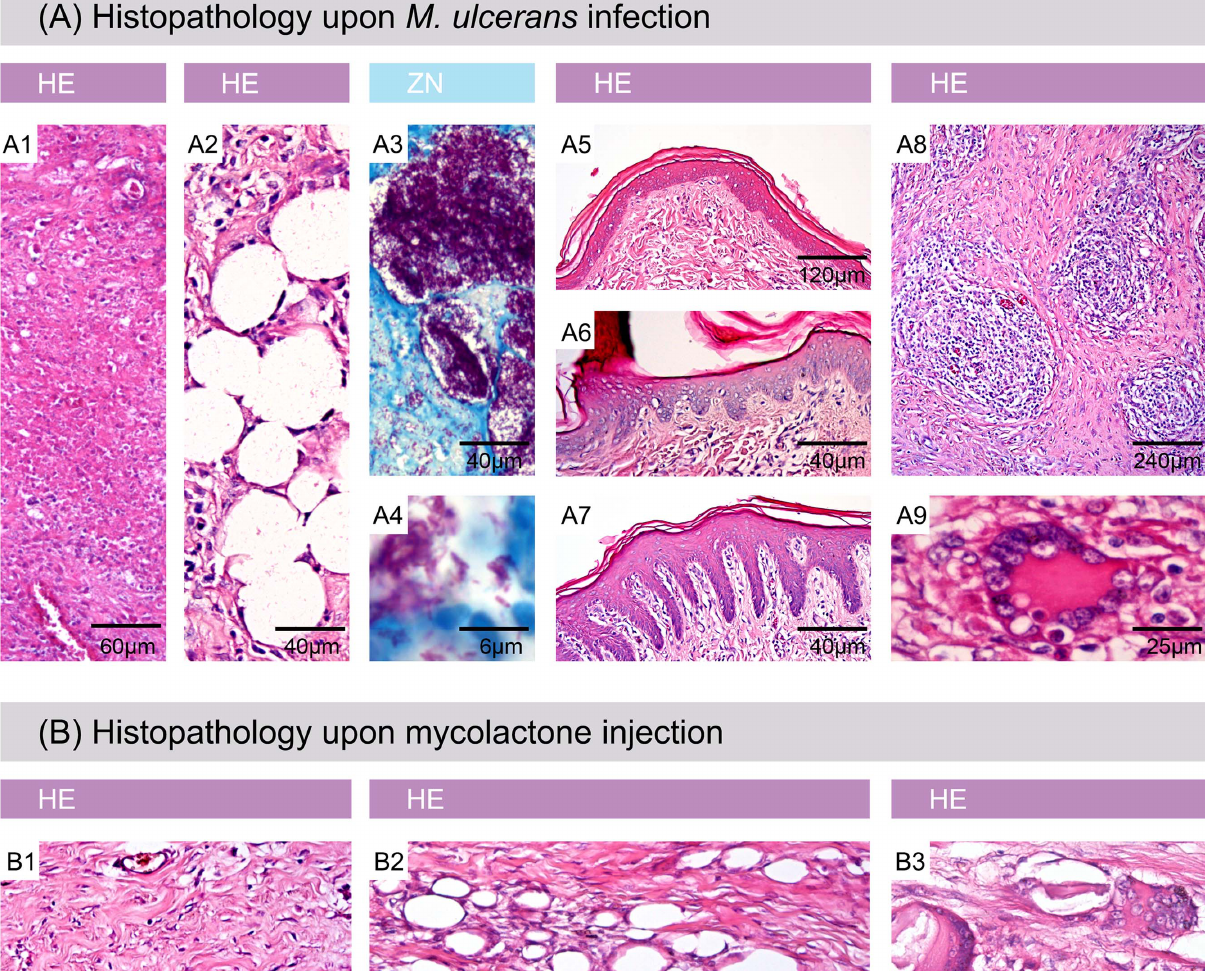
Figure 5. Histophathological hallmarks of Buruli ulcer in experimentally infected pig skin. Histologic sections stained with Haematoxylin/ Eosin (HE) (A1, A2, A5, A6, A7, A8, A9, B1, B2 and B3) or Ziehl-Neelsen/Methylene blue (ZN) (A3, A4). A: All typical histopathological features of BU in humans were found in infected pig skin. A1: necrosis, A2: fat cell ghosts, A3 and A4: extracellular clusters of AFB, A5: healthy epidermis, A6: moderate epidermal hyperplasia, A7: strong epidermal hyperplasia, A8: granuloma formation, A9: giant cells. B: Histopathological changes induced by mycolactone injection. B1: necrosis, B2: fat cell ghosts, B3: giant cells.